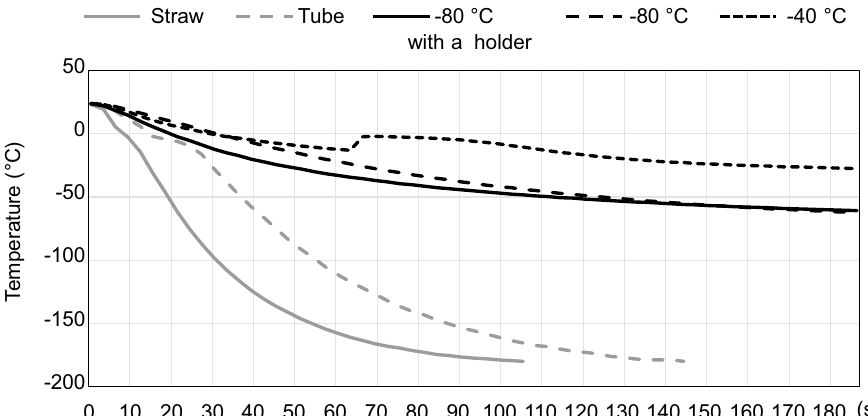
Figure 3. The cooling rates of mouse sperm suspensions frozen by various methods. Temperature changes were measured for the following conditions: the standard method using a plastic straw frozen in LN 2 (gray, solid line); using a cryotube frozen in LN 212 (gray, dotted line); the EQ method using a microtube frozen in a −80 °C freezer (black, solid line) or in a −40 °C freezer (black, fine dotted line). The EQ method without an aluminum foil stand was also tested (black, coarse dotted